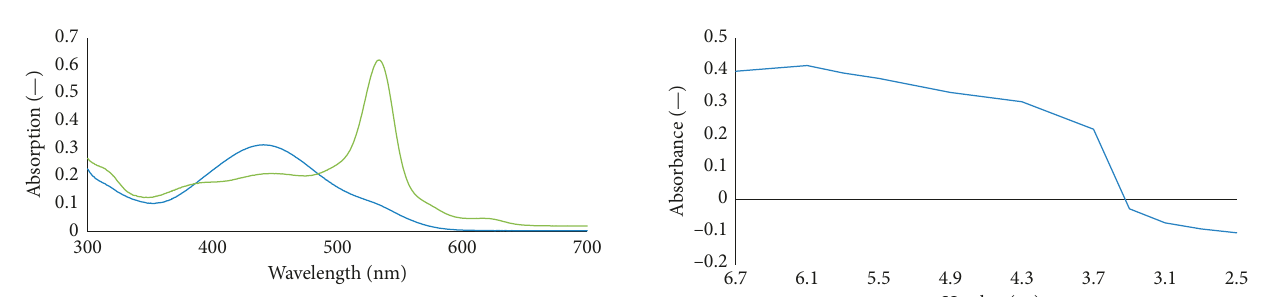
Figure 3: Spectra of eriochrome cyanine R (blue) and Al-ECR complexes (green) against distilled water with the following con- ditions: pH, 5.20; acetate buffer, 0.2M; Al 3+ , 7.4